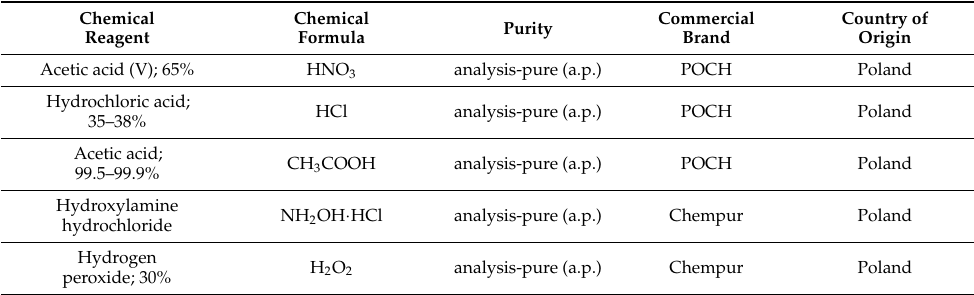
Chemical Formula Purity